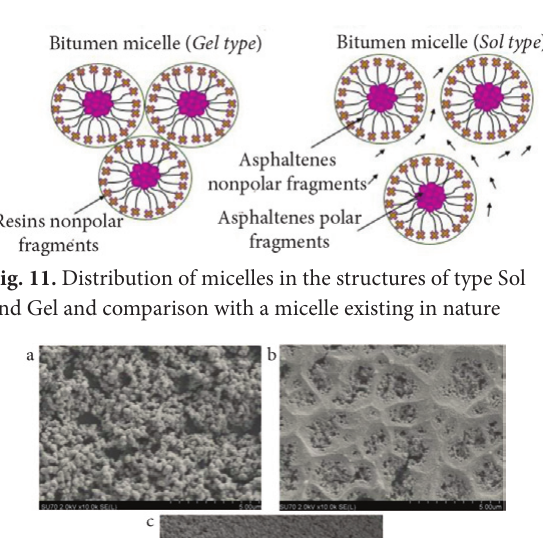
fig. 10. Micelle in the nature